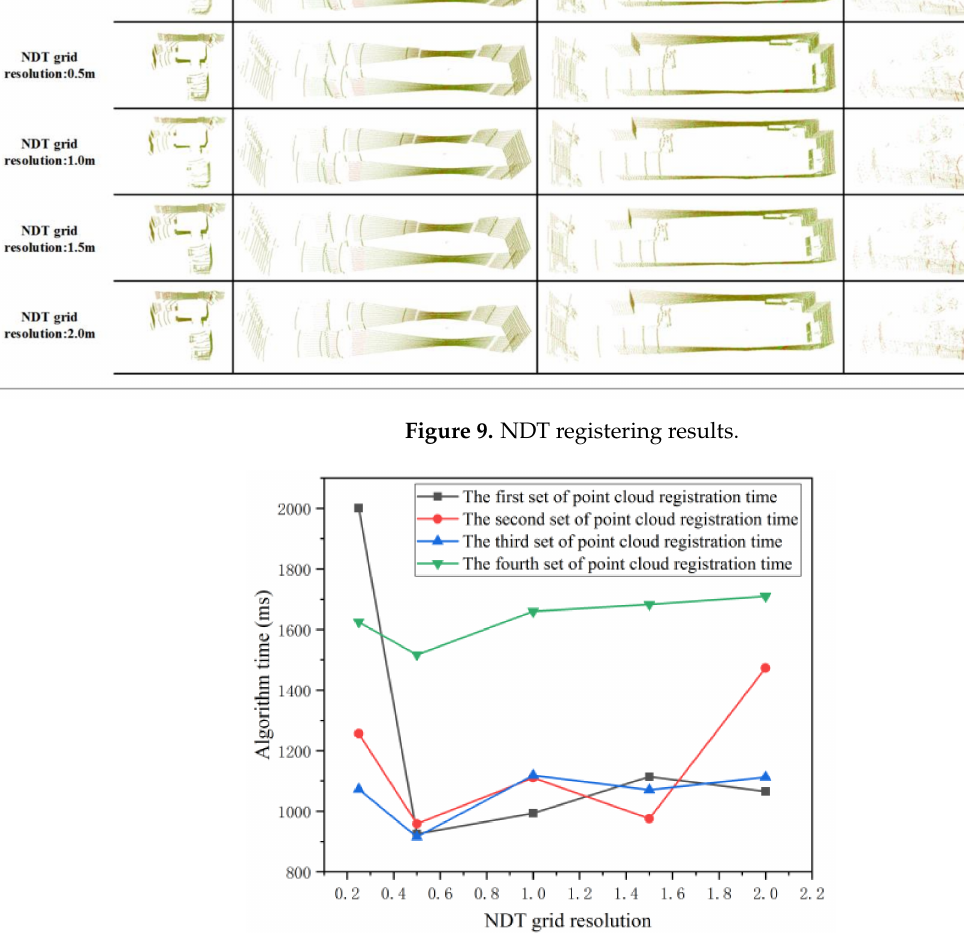
Figure 10. NDT registration